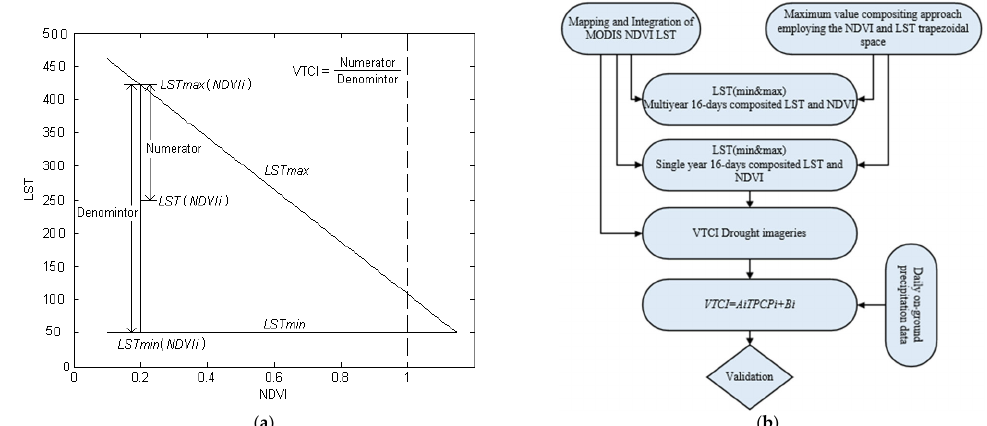
Figure 2. Schematic diagram of VTCI using the MVC method for drought, flood, and warm and cold edges, which are based on the linear regression equation. Where ( a ) presents the MODIS data from processing to validation using the VTCI approach, and ( b ) shows the trapezoid MVC method incorporating the single ‐ year and multiyear acquired data products’ composite LST and NDVI data, which yields the edges and drought imageries with a 16 ‐ day difference.